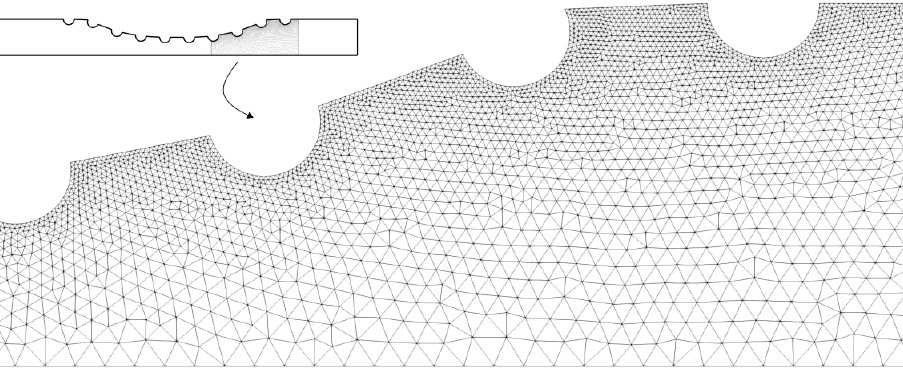
Figure 3. The unstructured quadratic triangular mesh for the Curved Channel with stent geometry. As can be seen, the mesh is more refinement close to the drug-eluting stent.